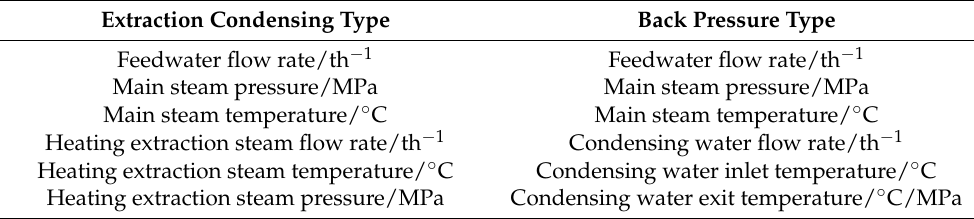
Table 2. The input parameters for different type of